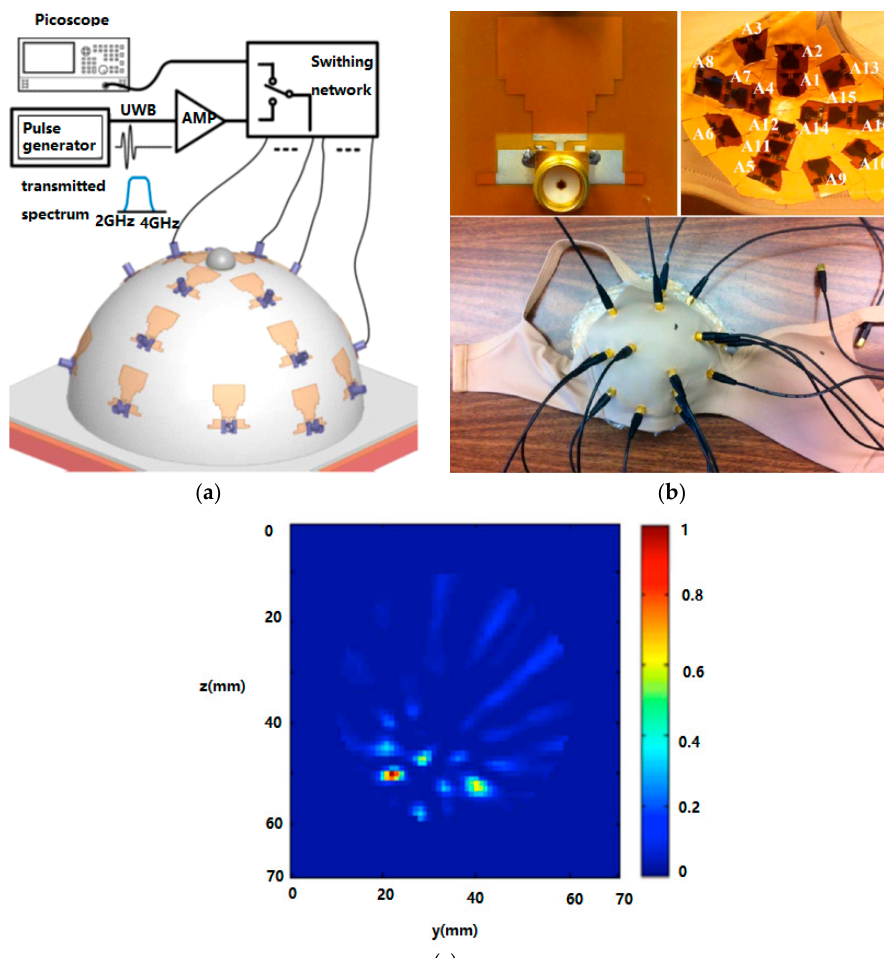
Figure 4. ( a ) Wearable microwave radar system; ( b ) prototype; ( c ) reconstructed human breast image.